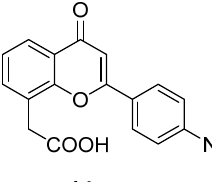
Figure 9. FAA analogue as affinity label.